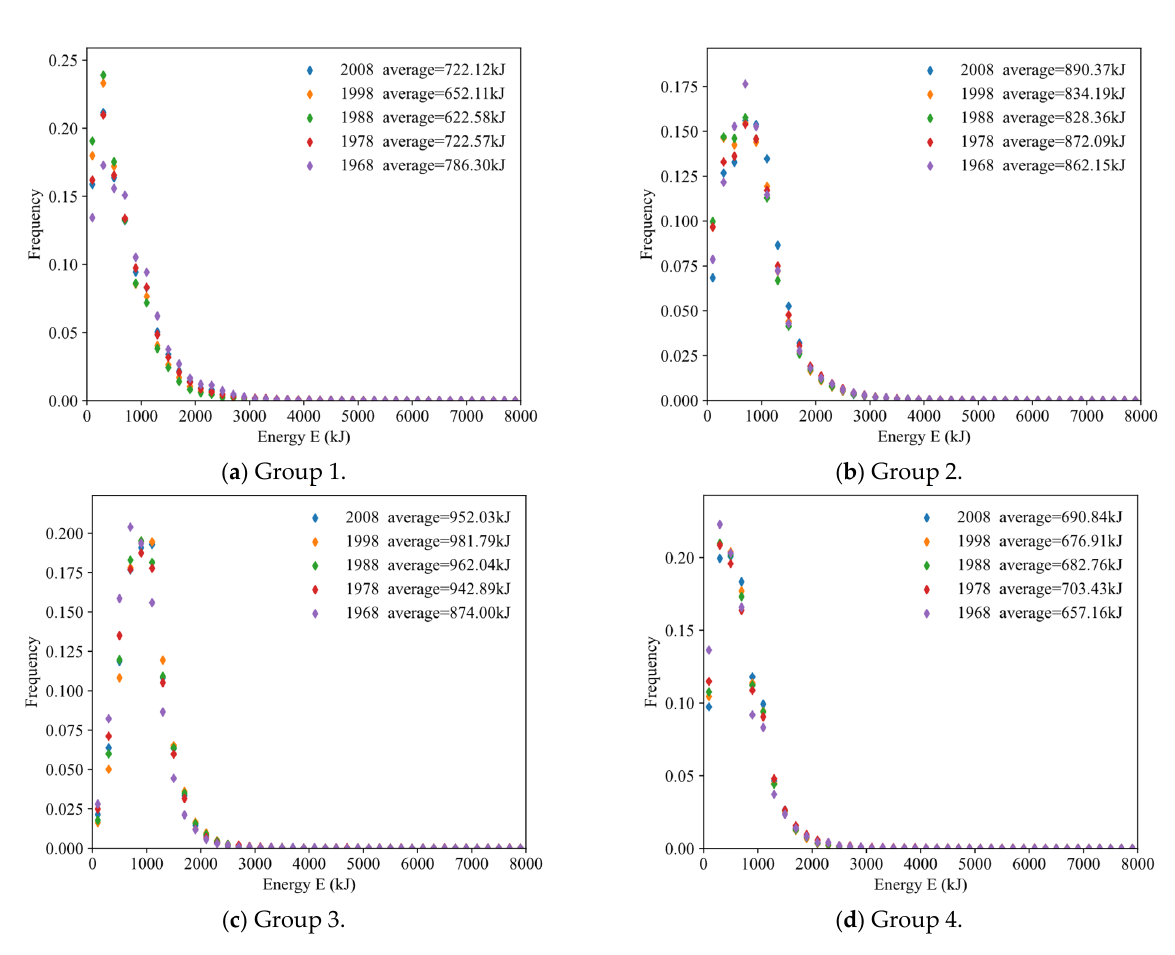
Figure A7. The distribution of daily energy expenditure for each group of people (bin width = 200 kJ). ( a ) Group 1; ( b ) Group 2; ( c ) Group 3; ( d ) Group 4.